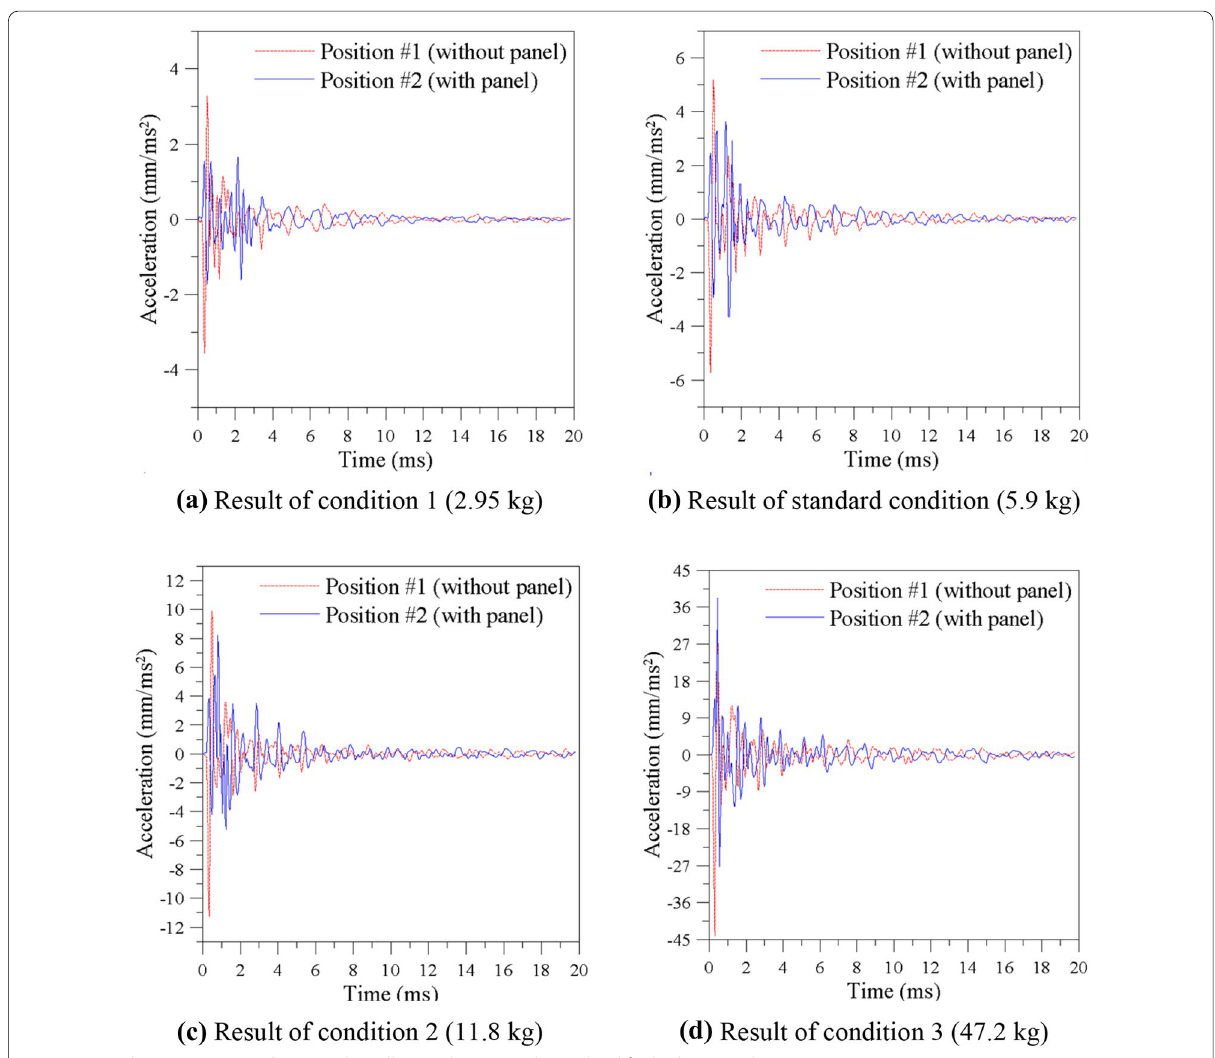
Fig. 16 Acceleration measured at outside wall according to explosion load for high‑strength concrete.